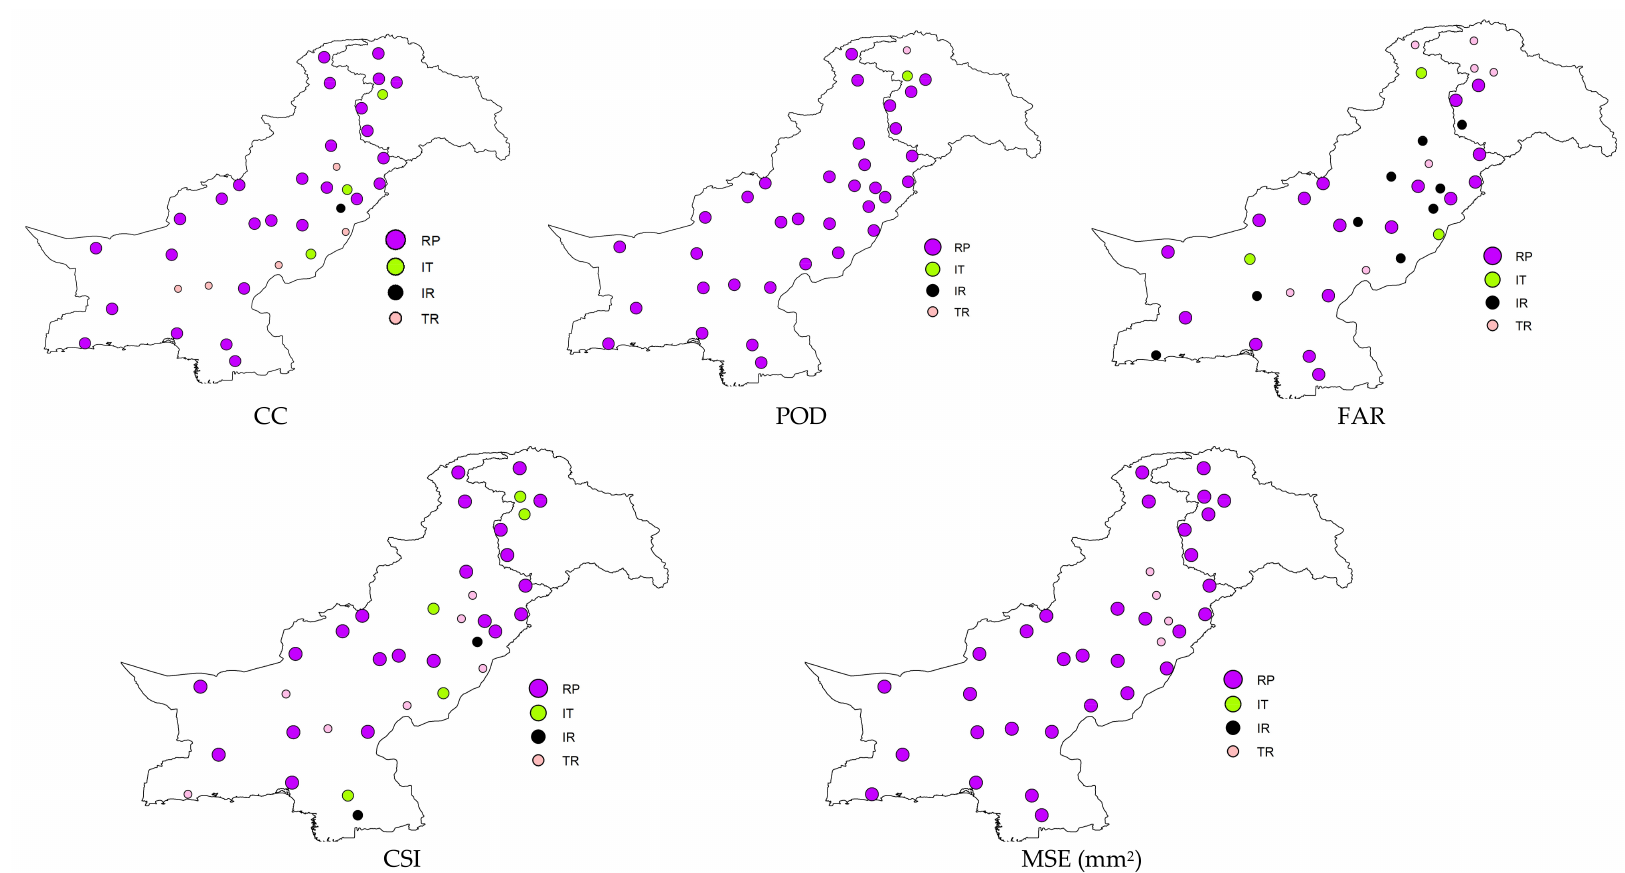
Figure 4. Comparative performance assessment for the RP, IR, IR, and TR, at each